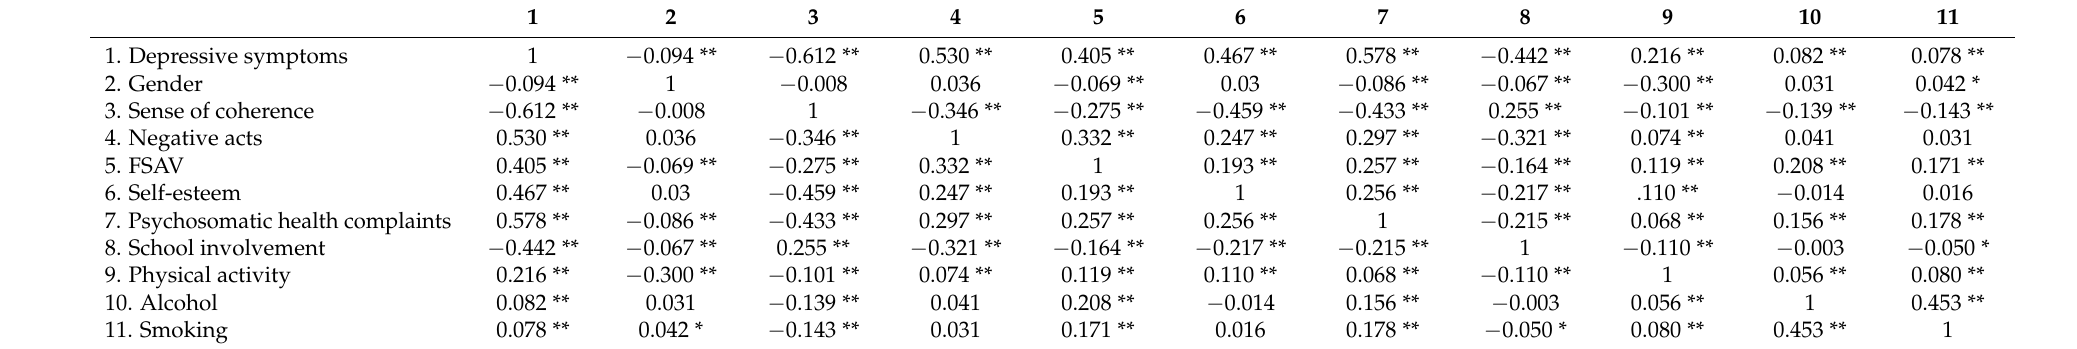
Table 1. Correlations of study